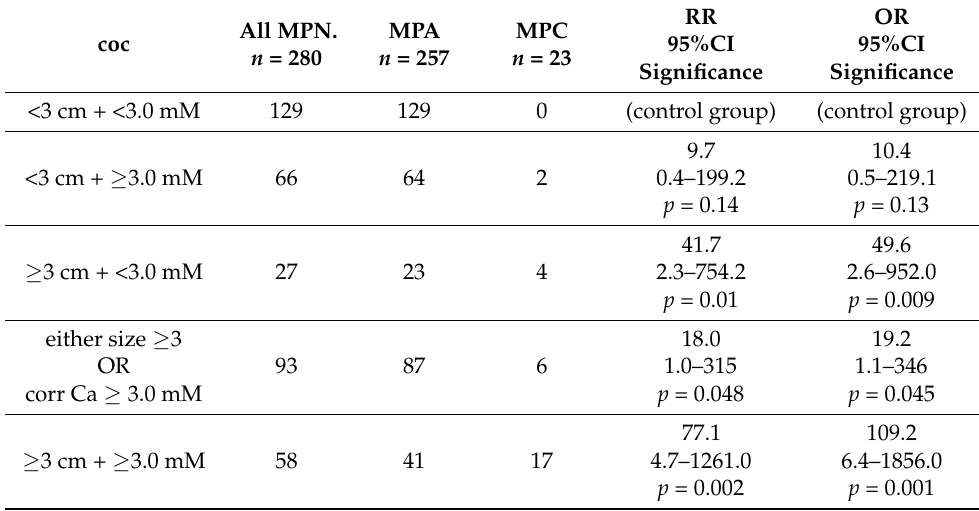
Table 3. Lesion size and corrected calcium define the cancer risk of in mediastinal parathyroid neoplasms